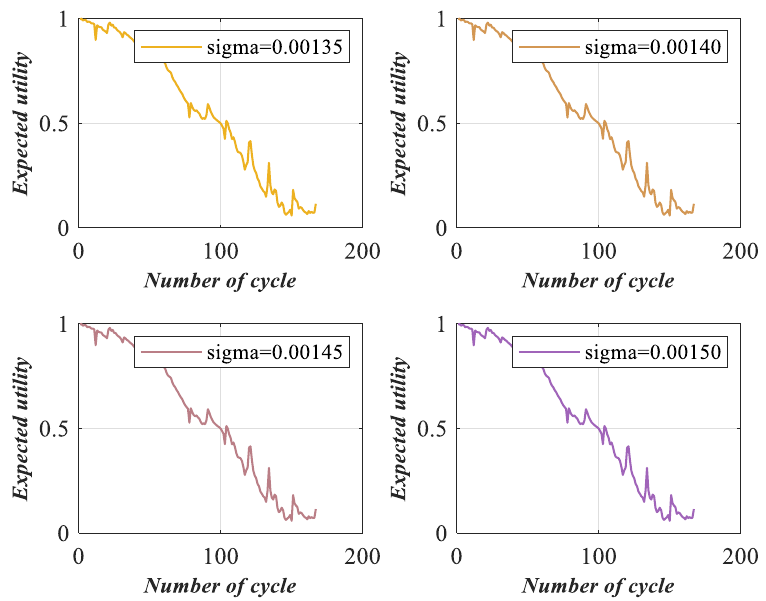
Figure 11. Expected utility of lithium-ion battery health status under different perturbation intensities.